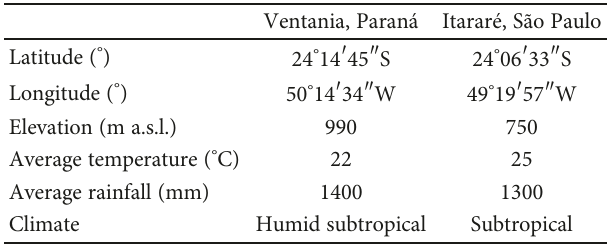
Figure 2: Location of the sites sampled: (1) Ventania, Paraná, and (2) Municipality of Itararé, Sao Paolo. Table 2: Location and description of sampling sites.